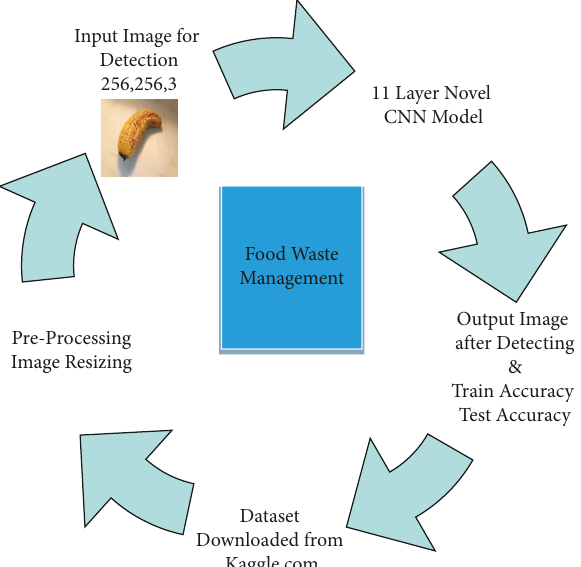
Figure 3: Block diagram of the proposed model.